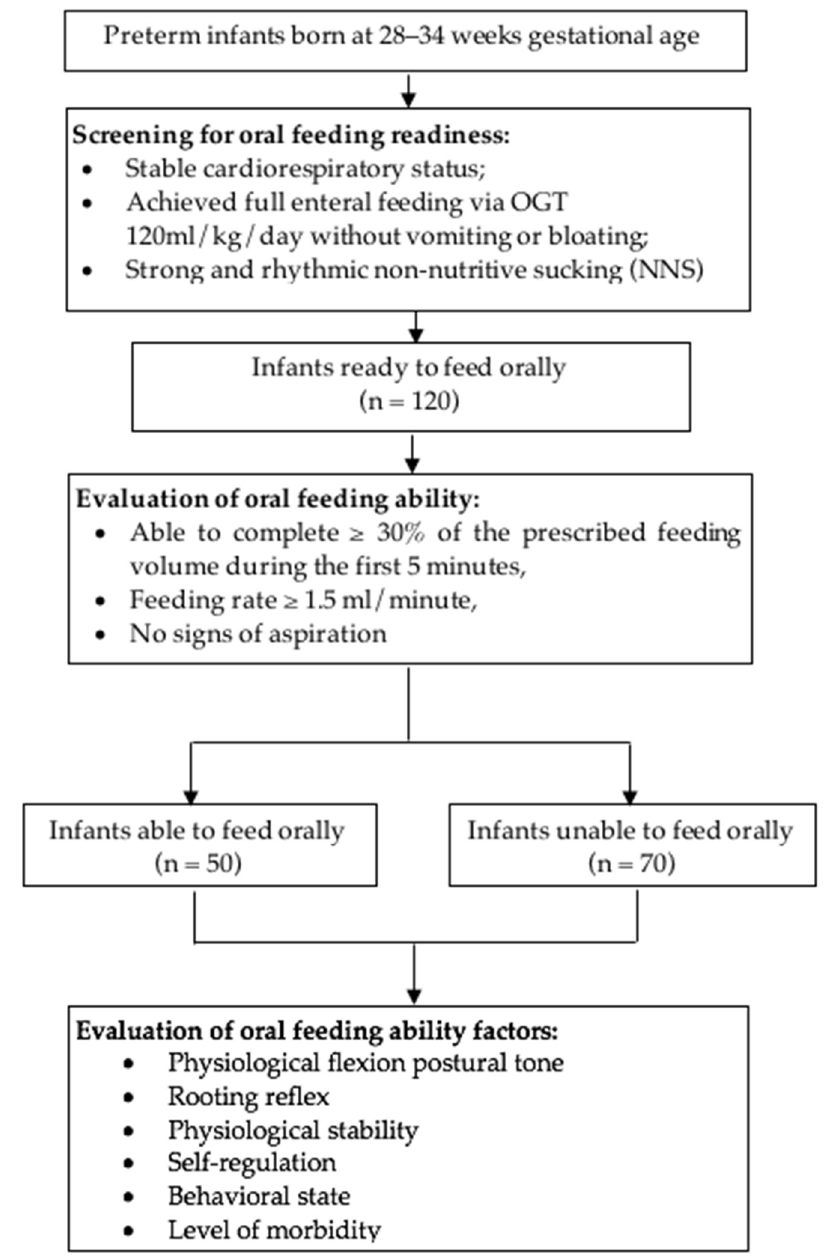
Figure 1. Flowchart of the study.